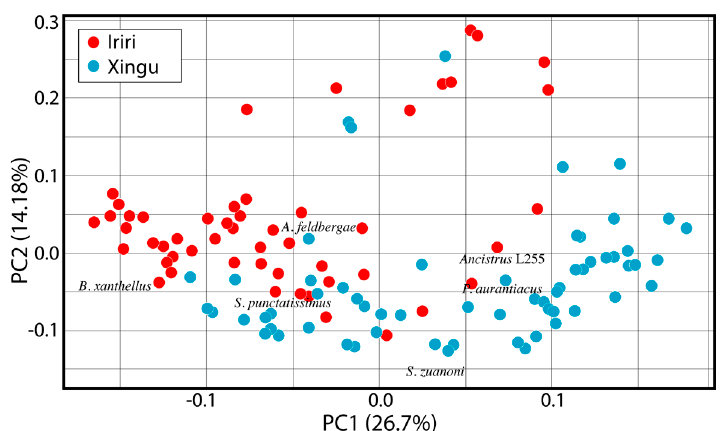
FIGURE 4 | Principal Component Analysis (PCA) of fish composition in the drainages of both the Xingu and Iriri River RESEXes (Hellinger transformation). Only species names that made greatest contributions to compositional differences are